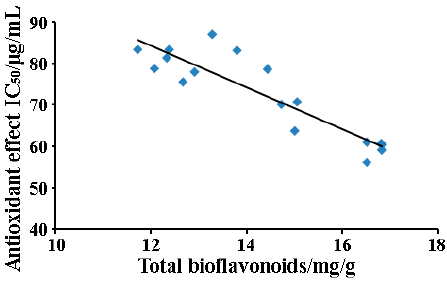
Figure 6. The correlation between total biflavonoids content and IC 50 values of DPPH radicals scavenging.